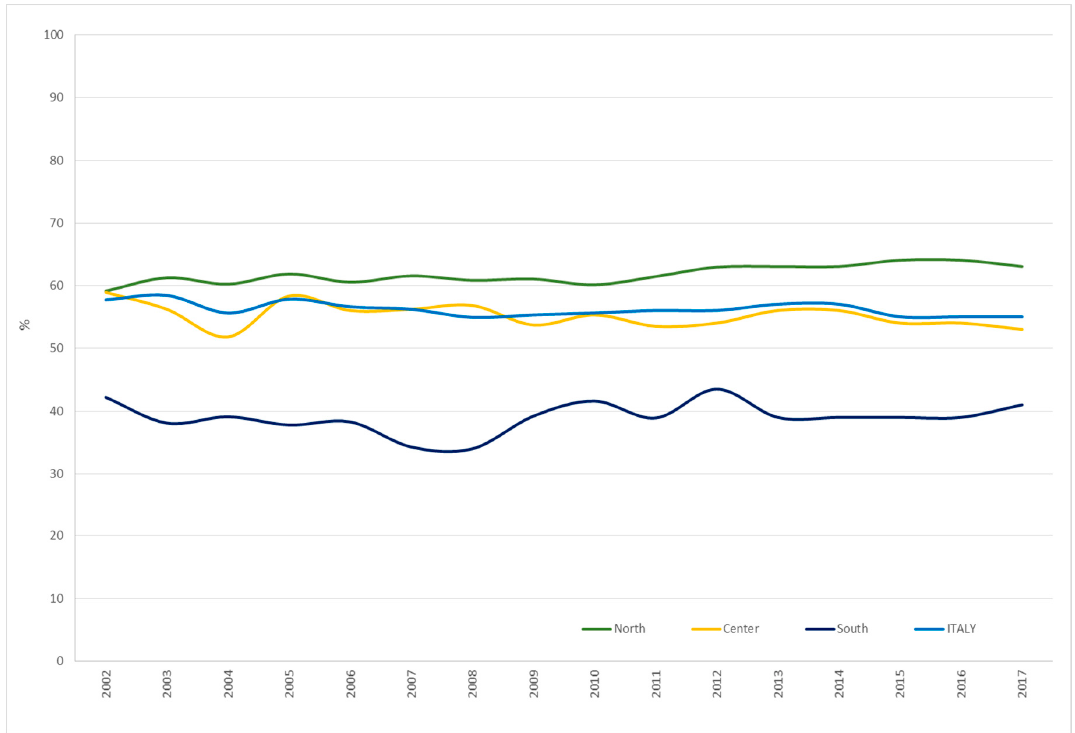
Figure 6. Participation in mammography screening among women between 50–69 years old in Italy overall and by area of residence. Italy, 2002–2017. Source: National Centre for Screening Monitoring (ONS).